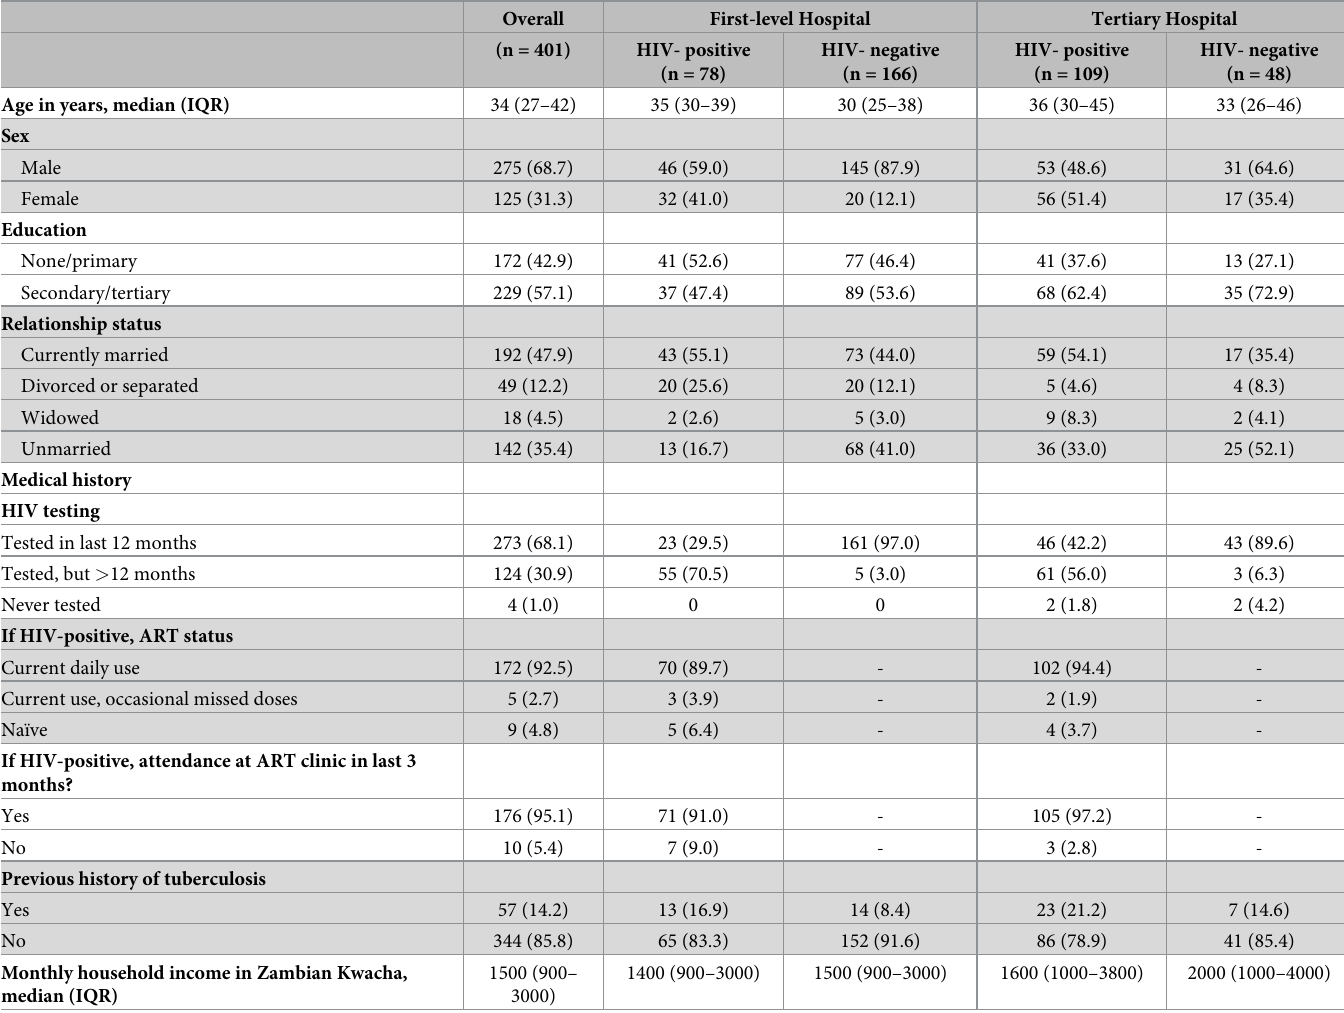
Table 2. Baseline characteristics by enrollment site and HIV